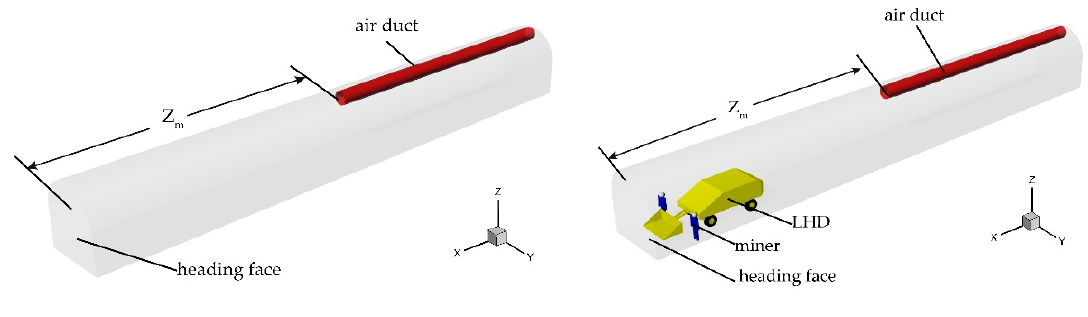
Figure 7. Geometric model ( a , b ).